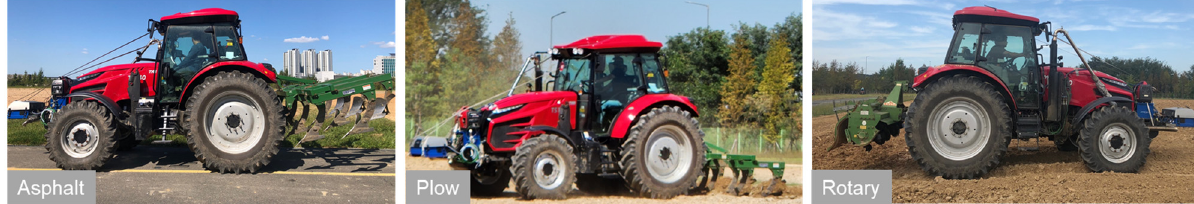
Figure 7. The experiment using a 95-kW partial PST tractor.